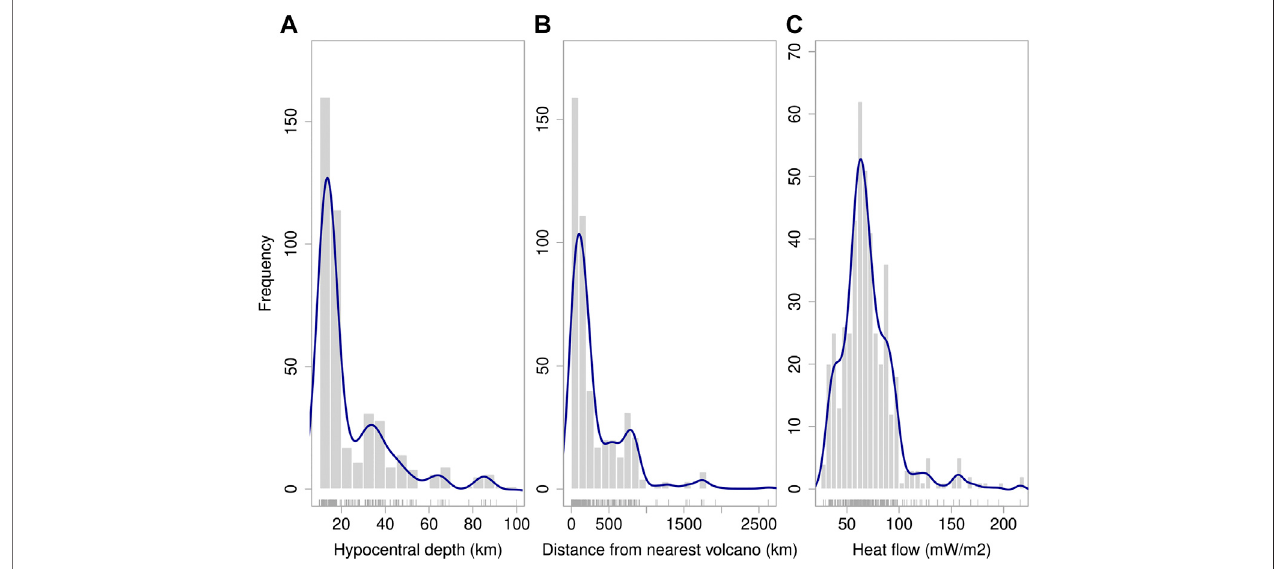
FIGURE 3 | Frequency histogram (over 453 total cases) of (A) average hypocentral depths, (B) distances from the nearest volcano and (C) heat fl ow values associated with each cataloged seismic precursor.